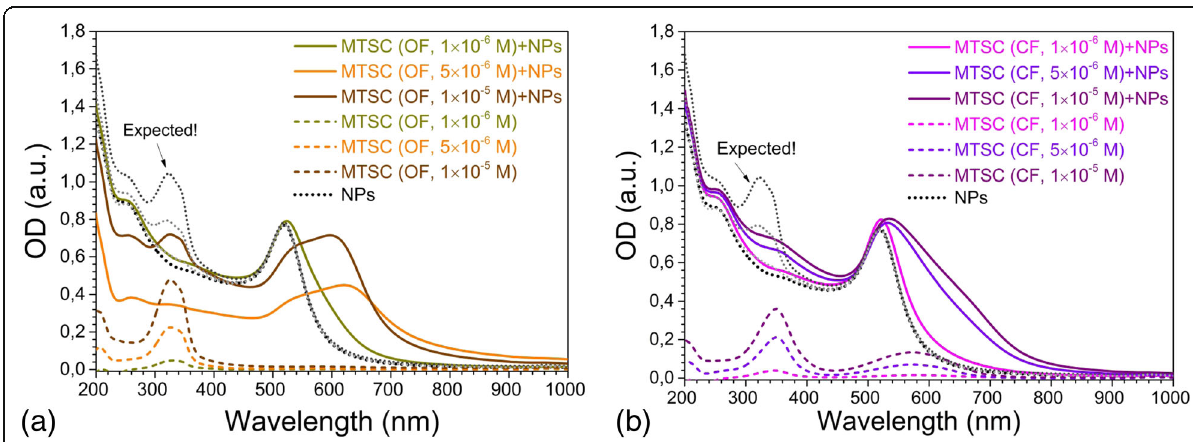
Fig. 3 Changes in absorption spectra of gold nanoparticles influenced by C5F-MTSC in OF ( a ) and CF ( b ); dotted lines show the spectra of C5F-MTSC in control measurements. The volume ratio of water to ethanol was equal to 4:1. The DAE concentrations were C DAE =1×10 − 6 , 5×10 − 6 , 1×10 − 5 M. The concentration of gold C Au =2×10 − 4 M was constant for all series